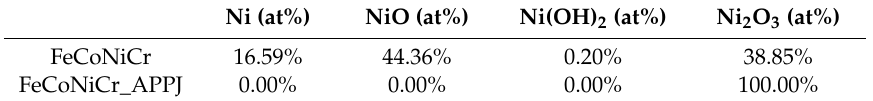
Table 6. XPS Ni2p deconvoluted peak areal ratios from XPS spectra shown in Figure 10.